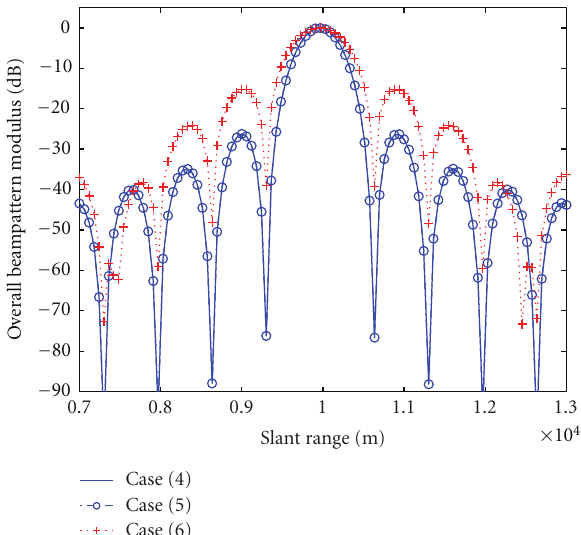
Figure 6: The comparative overall beampatterns in range dimen- sion when Δ f / = 0.